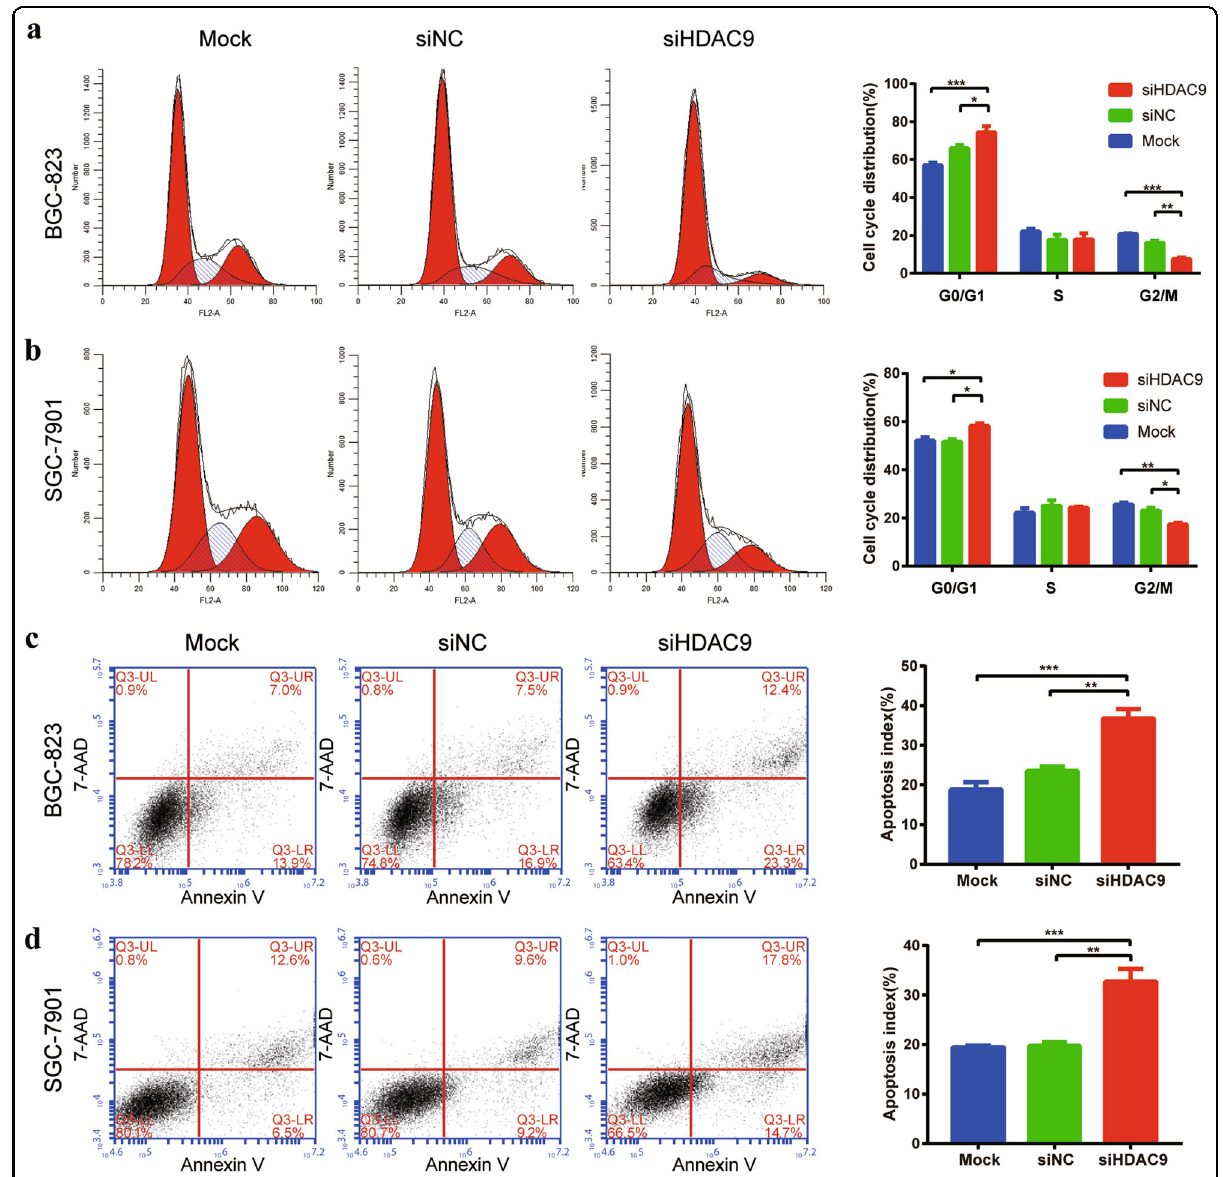
Fig. 6 HDAC9 silencing induced cell cycle arrest and apoptosis. a , b Cell cycle analysis of PI-stained mock-, siNC-, and siHDAC9-treated cells for 48 h by fl ow cytometry. The histogram peaks indicate the G1/G0, S, and G2/M phases of the cell cycle. The results show that HDAC9 silencing induced G1 arrest and reduced the proportion of cells in G2/M phase. c , d HDAC9 inhibition promoted the induction of apoptosis in GC cell lines, as evidenced by the Annexin V-PE/7-AAD assay. The apoptotic index was obtained from the ratio of early to late apoptotic cells. The error bars indicate the means ± SDs; * p < 0.05, ** p < 0.01, *** p < 0.001 versus the control